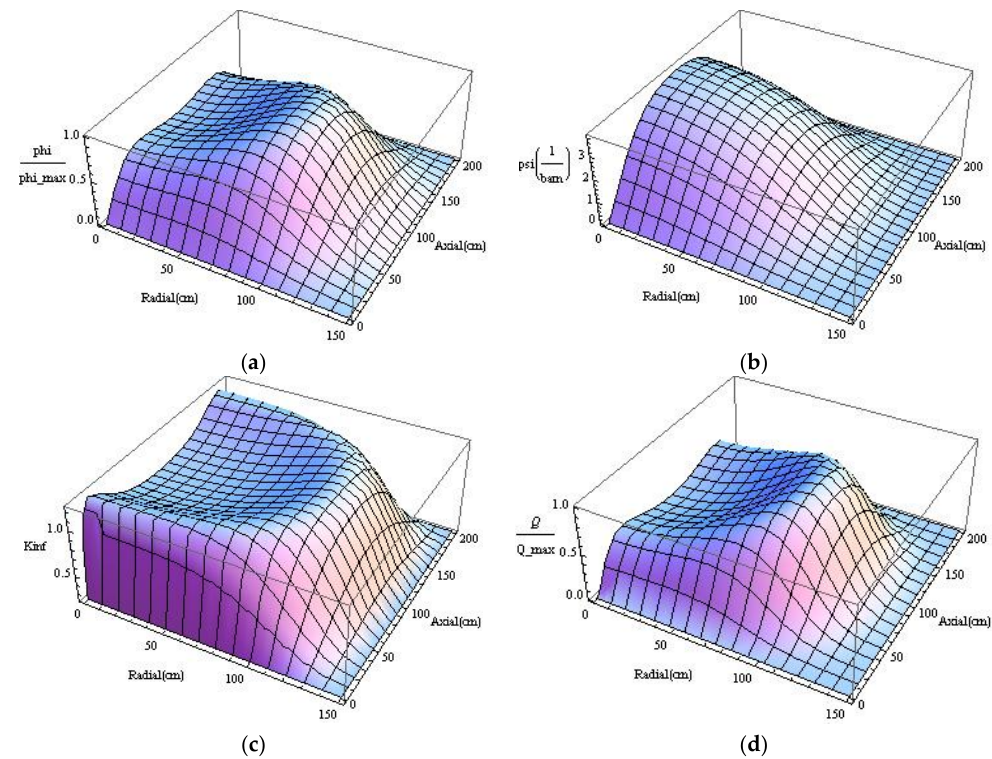
Figure 8. Distributions of neutron flux φ , fluence ψ , infinity multiplication factor k inf and the normalized power density in Case 1 in Table 3. ( a ) Neutron flux; ( b ) neutron fluence; ( c ) infinity multiplication factor; ( d ) power density.